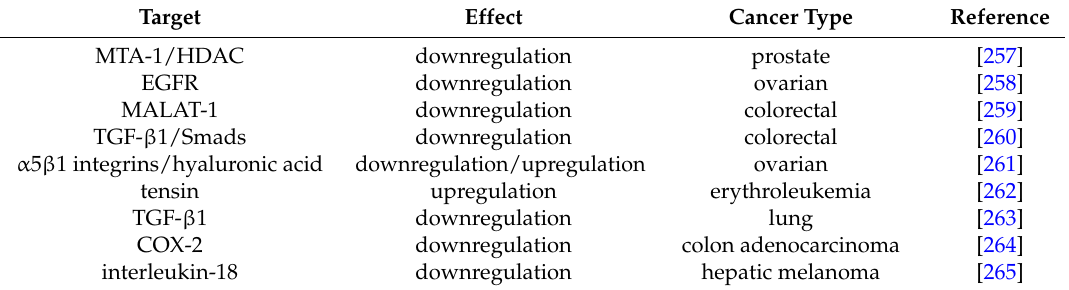
Table 3. Antimetastatic targets for